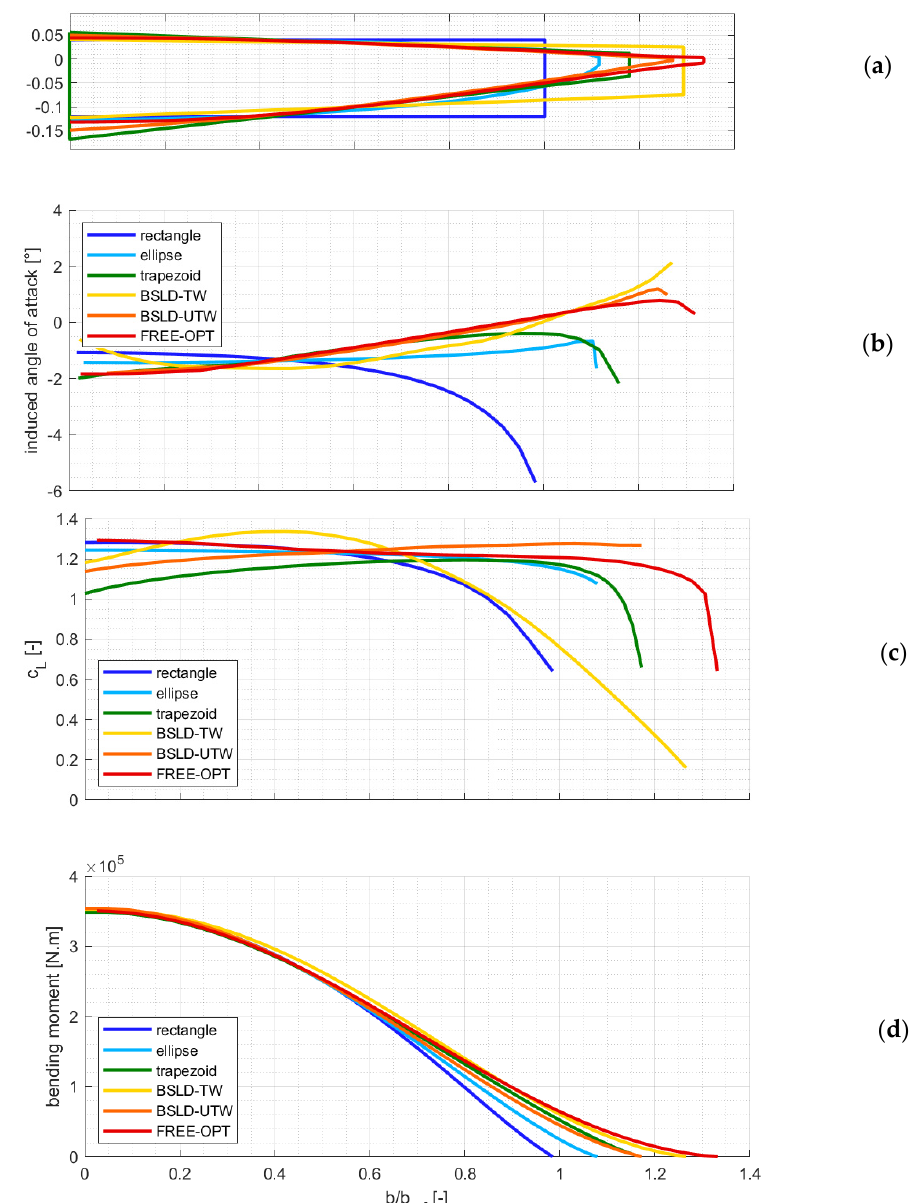
Figure 7. This series shows a comparison of the aerodynamic characteristics of selected wings. On the picture ( a ) is depicted geometry of the wings and their different planforms, ( b ) shows comparison of induced angle of attack, ( c ) distribution of lift coefficient over the semispan, ( d ) bending moment coefficient over the semispan.